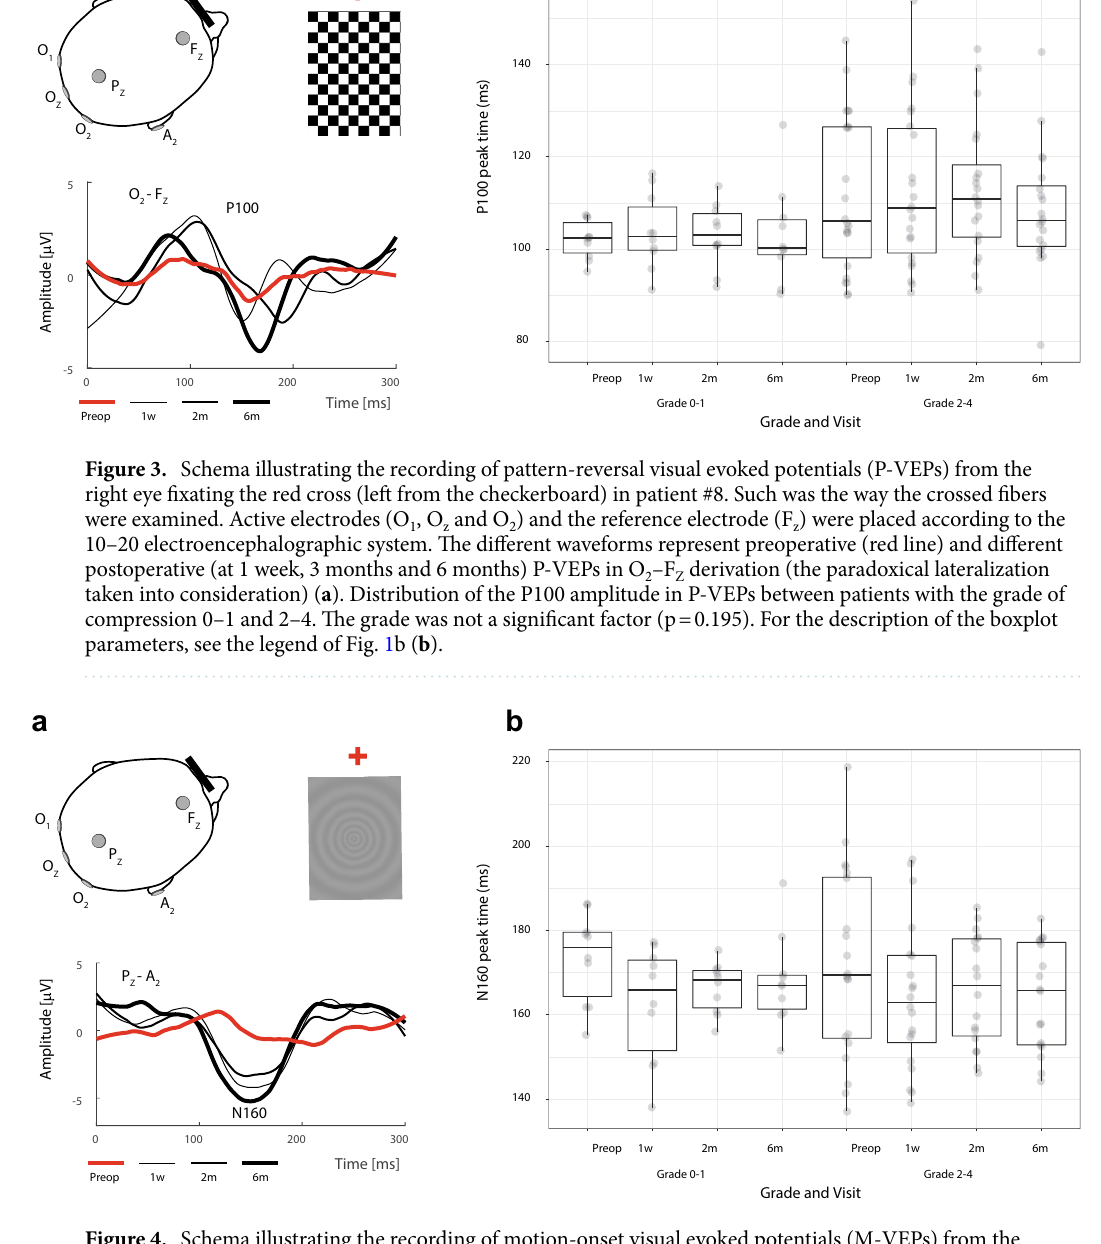
Figure 4. Schema illustrating the recording of motion-onset visual evoked potentials (M-VEPs) from the right eye fixating the red cross (left from the pattern) in patient #8. Such was the way the crossed fibers were examined. Active electrodes (O 1 , O z , O 2 and P z ) and the reference electrode (A 2 ) were placed according to the 10–20 electroencephalographic system. The different wave forms represent preoperative (red line) and different postoperative (at 1 week, 3 months and 6 months) M-VEPs in P Z –A 2 ( a ). Distribution of the N160 amplitude in M-VEPs between patients with grade of compression 0–1 and 2–4. The grade was not a significant factor (p = 0.696). For the description of the boxplot parameters, see the legend of Fig. 1b ( b Surgery. The same operating team performed all decompressive procedures. Transcranial surgery was elected in two (12.5%) patients. In the remaining 14 surgeries, decompression was achieved via the transnasal transsphenoidal route, in which a microscope was used in five of the cases and an endoscope in nine. Statistical analysis. Statistical analysis was performed using the software R 3.5.1 33 . Using the Anderson– Darling test (“nortest” package), we tested the normality of the data distribution. Data evaluation and interpre- tation is related to eyes and not to patients, mainly because the lesions do not symmetrically compress the OC or the respective optic nerves. Another reason is that crossing fibers are compressed mostly just anterior to the